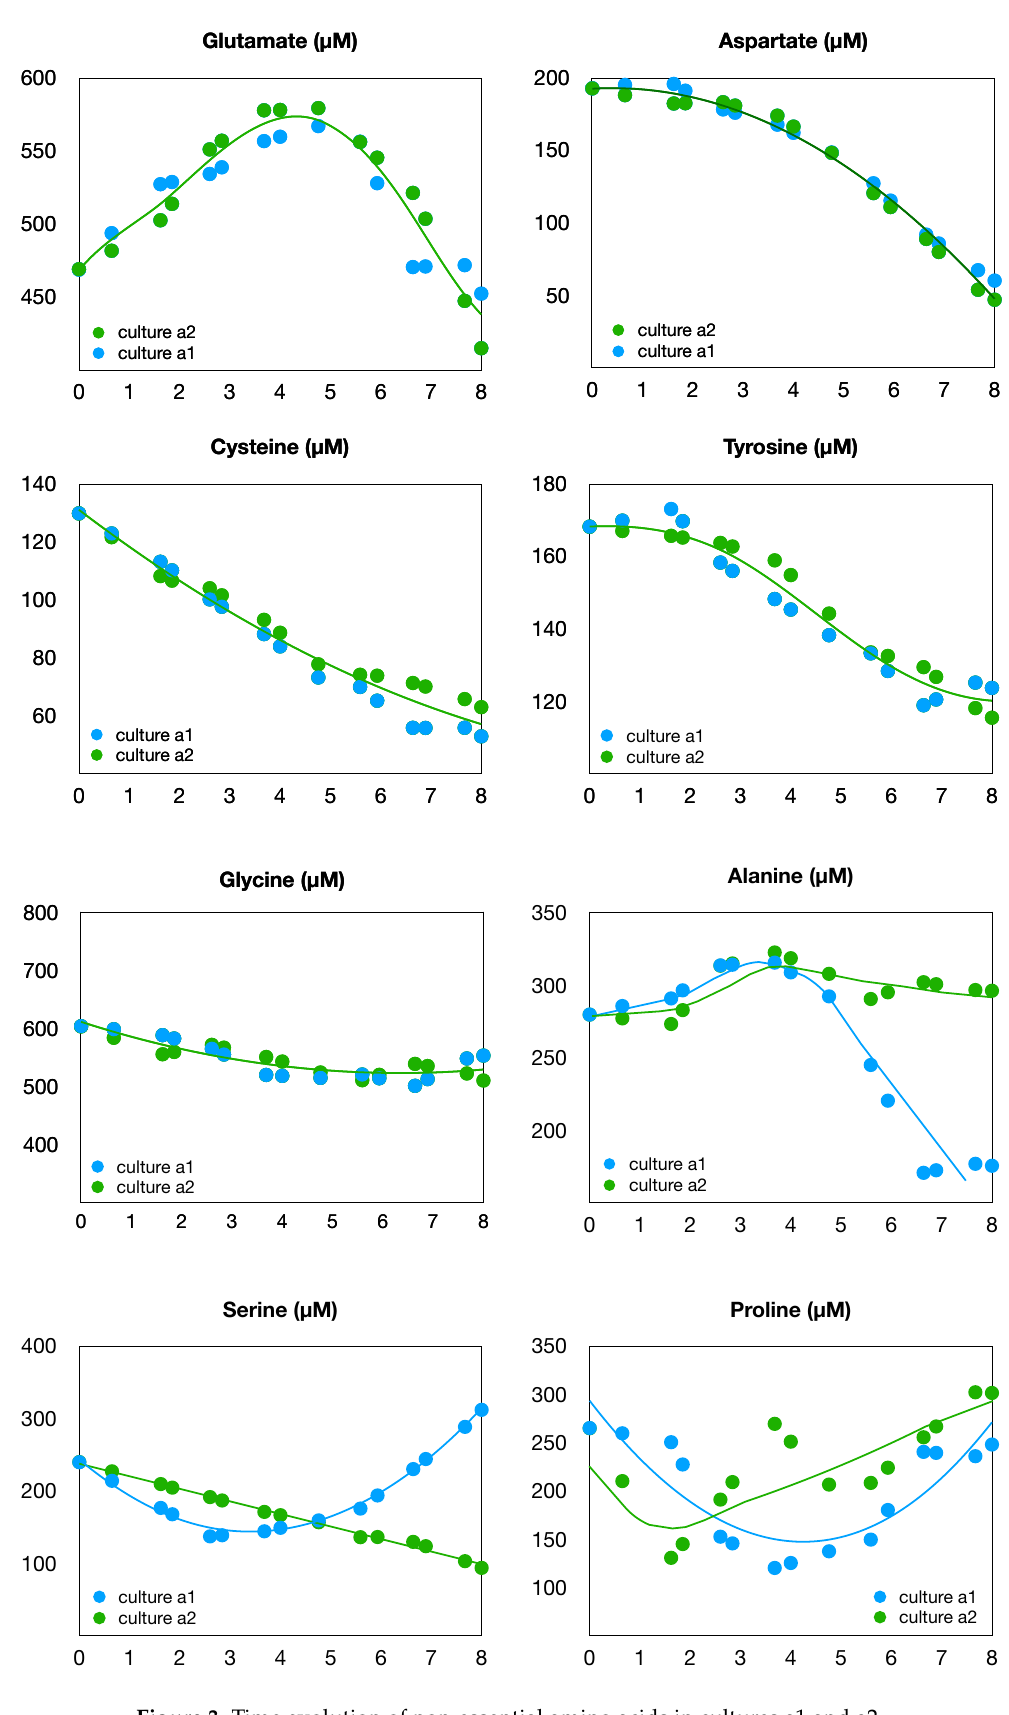
Figure 3. Time evolution of non-essential amino acids in cultures a1 and